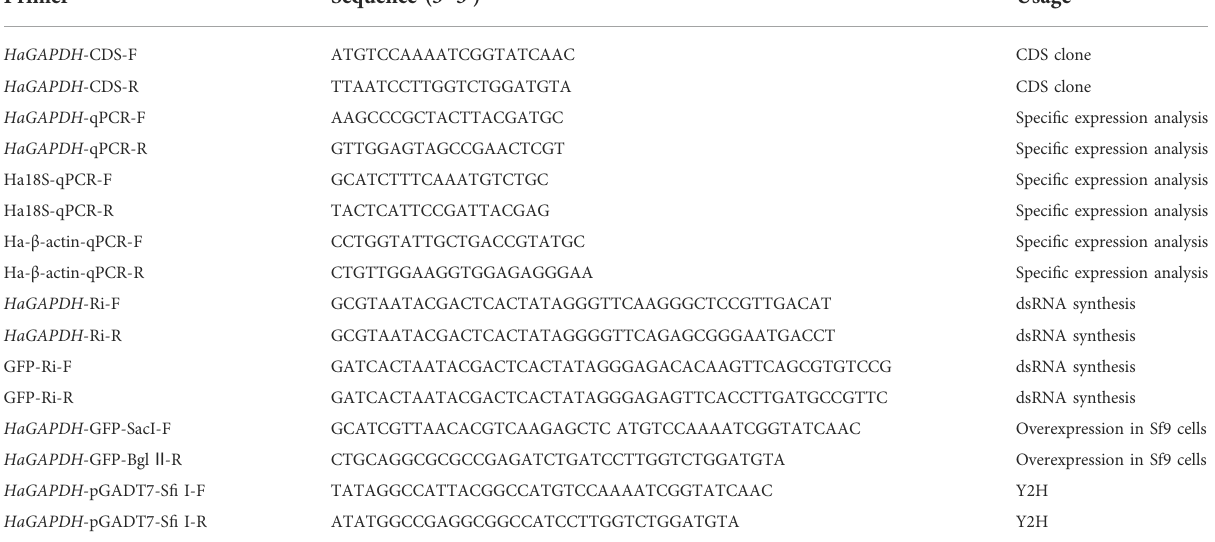
TABLE 1 Primers used in the